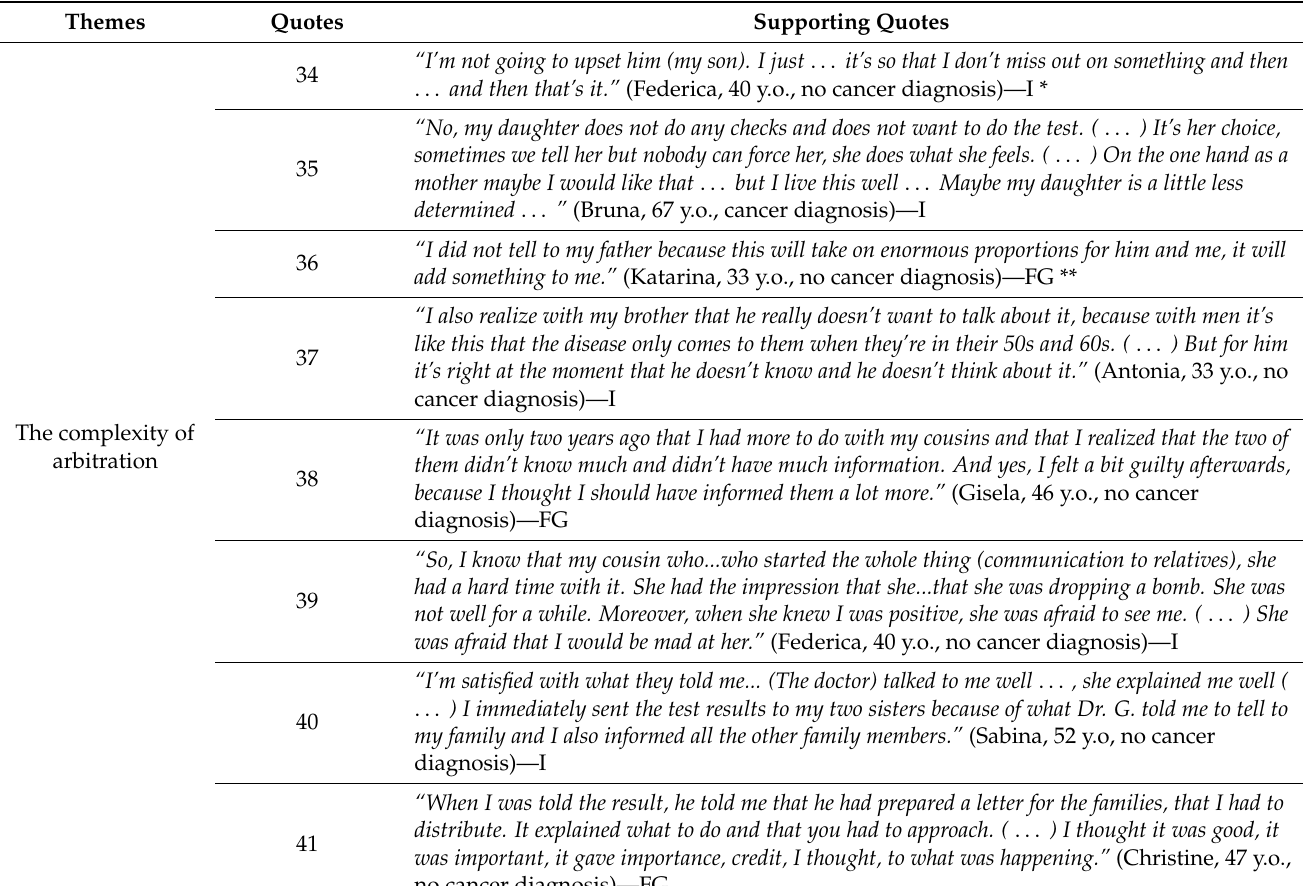
Table 5. Supporting quotes about “The complexity of